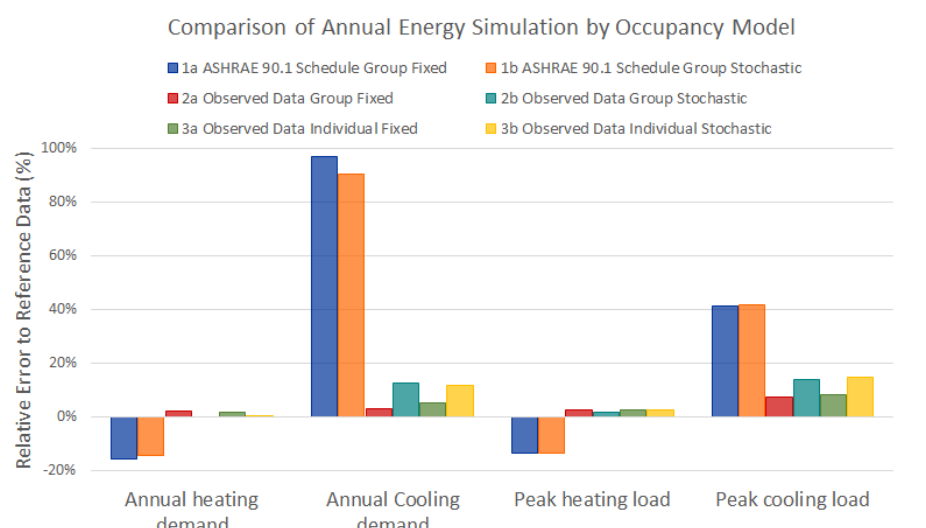
Figure 3. Results of building performance simulation (BPS) model accuracy from 2017 study. Adapted from Reference